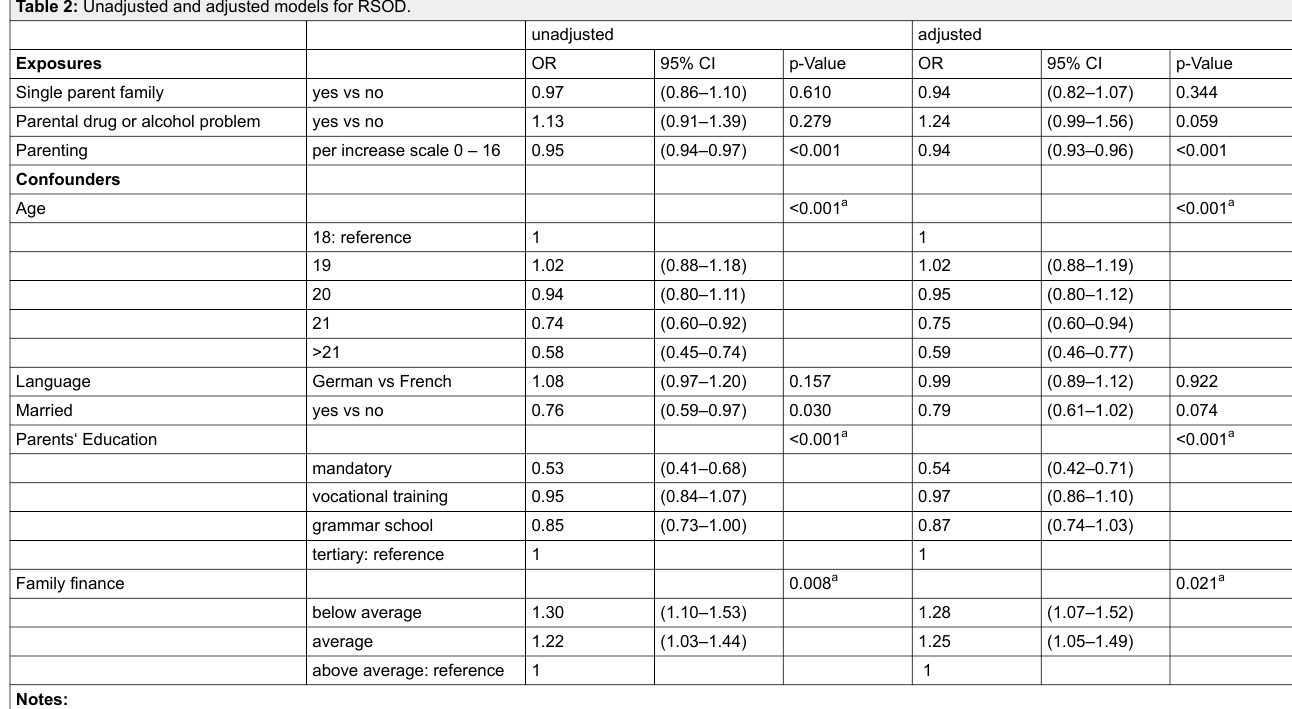
Table 2: Unadjusted and adjusted models for RSOD.